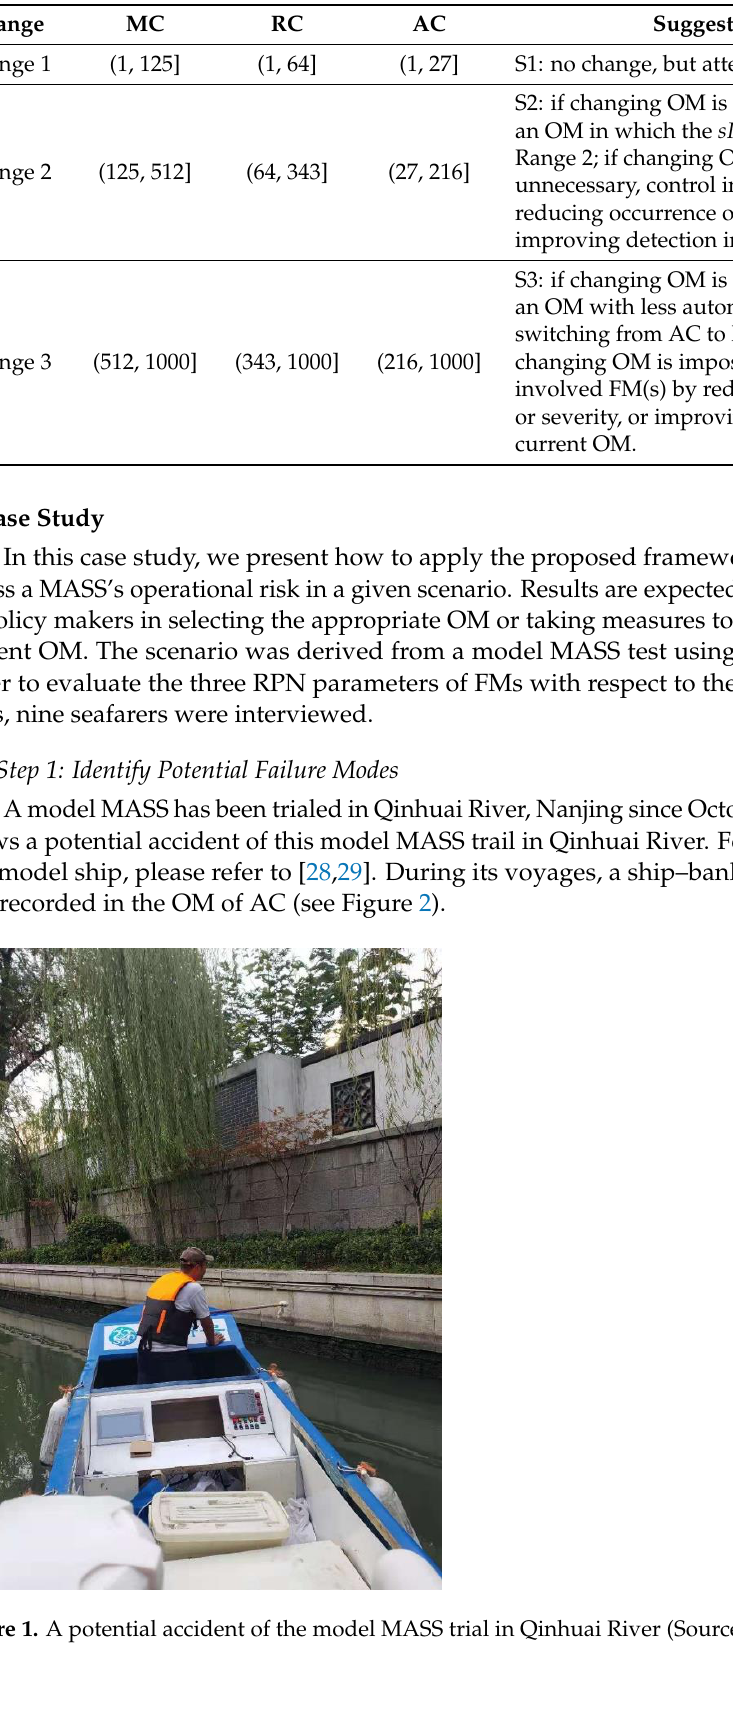
Figure 2. Accident paths of model MASS in autonomous control. Sluice gate Quay Bridge (without pile)